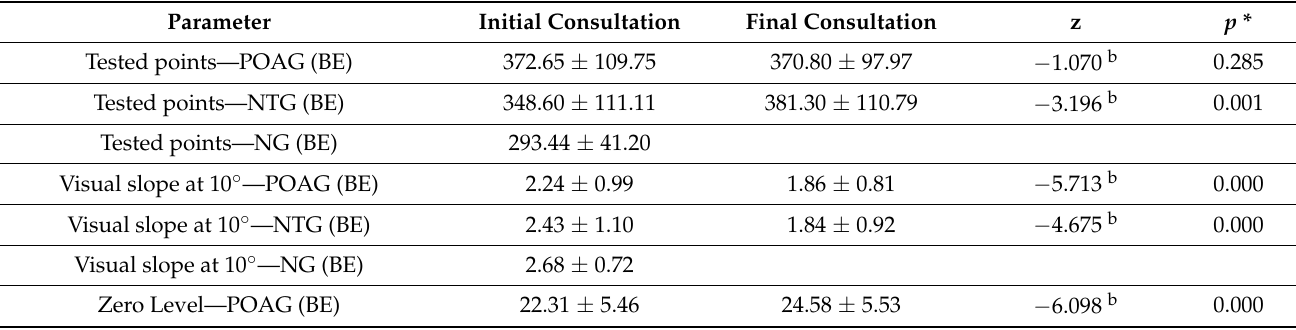
Table 5. Distribution of VF parameters result between the first and last consultation in POAG, NTG, and NG